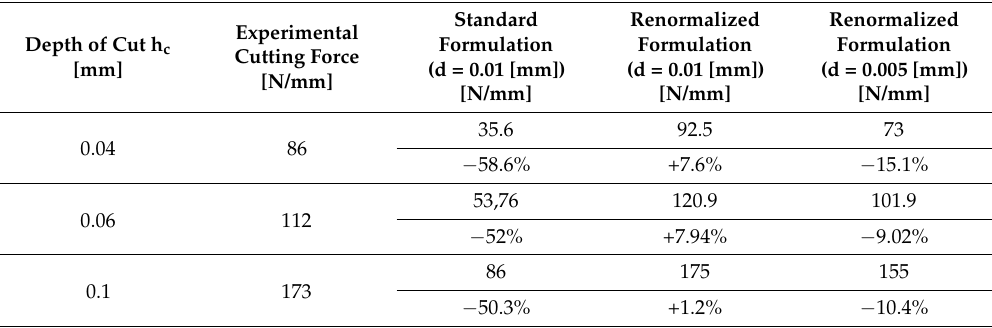
Table 4. Comparison between predicted and experimental cutting forces F c for all models.